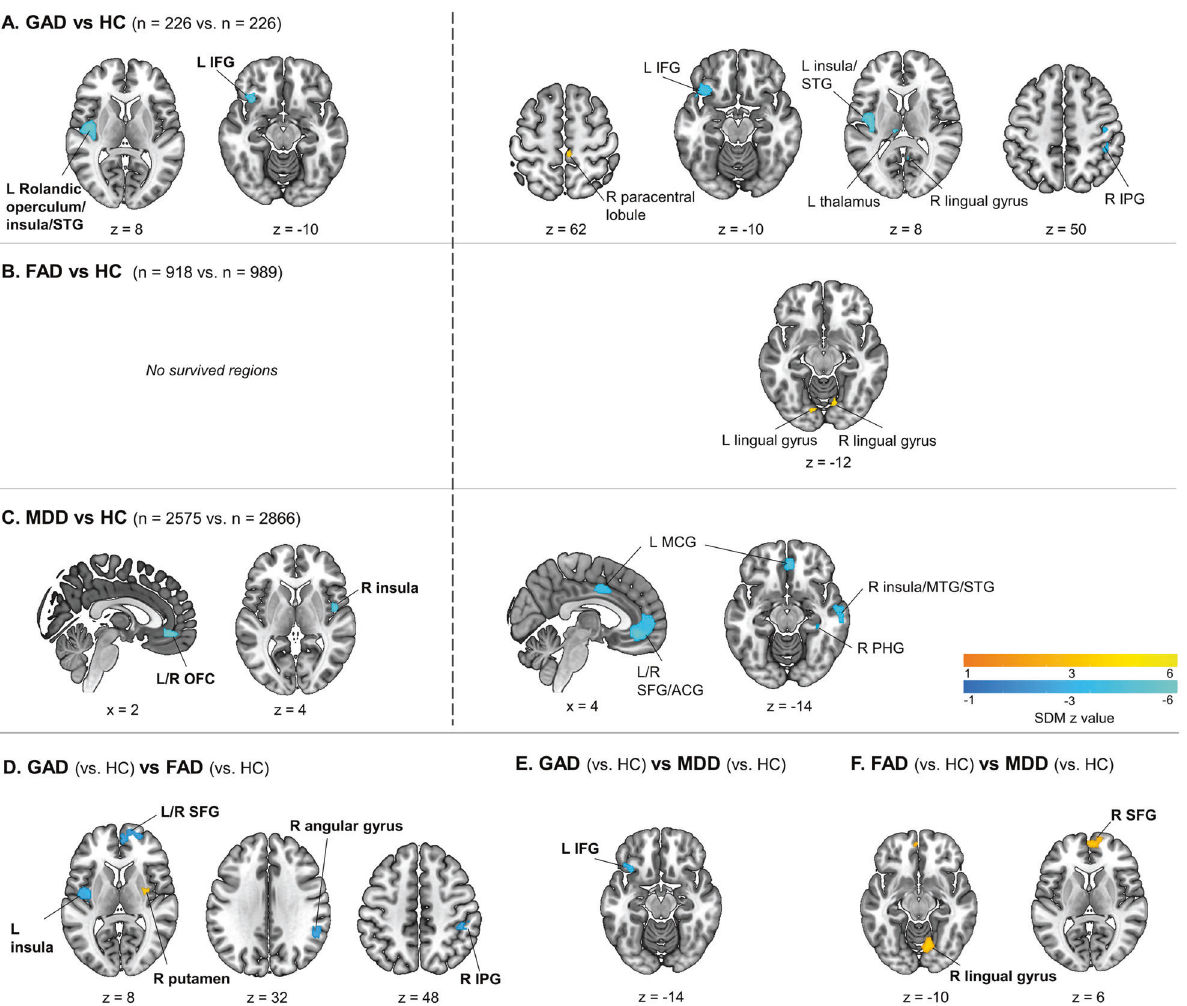
Fig. 2 Common and disorder-speci fi c gray matter volume alterations. Results of whole-brain meta-analysis of brain gray matter volume (GMV) among generalized anxiety disorder (GAD), fear-related anxiety disorder (FAD) and major depressive disorder (MDD). A Meta-analytic results for GAD relative to healthy controls (HC), B Meta-analytic results for FAD relative to HC, C Meta-analytic results for MDD relative to HC. The left panel shows brain regions signi fi cant at p < 0.05, TFCE corrected. The right panel shows brain regions signi fi cant at p < 0.0025, uncorrected. D Meta-analytic results for GAD (vs HC) in comparison to FAD (vs HC) covarying for age and sex, E Meta-analytic results for GAD (vs HC) in comparison to MDD (vs HC) covarying for age and sex, and F Meta-analytics results for FAD (vs HC) in comparison to MDD (vs HC) covarying for age and sex. Group comparisons are shown at p < 0.05, TFCE corrected. ACG anterior cingulate gyrus, IFG inferior frontal gyrus, IPG inferior parietal gyrus, L left, MCG median cingulate/paracingulate gyri, mPFC medial prefrontal cortex, MTG middle temporal gyrus,